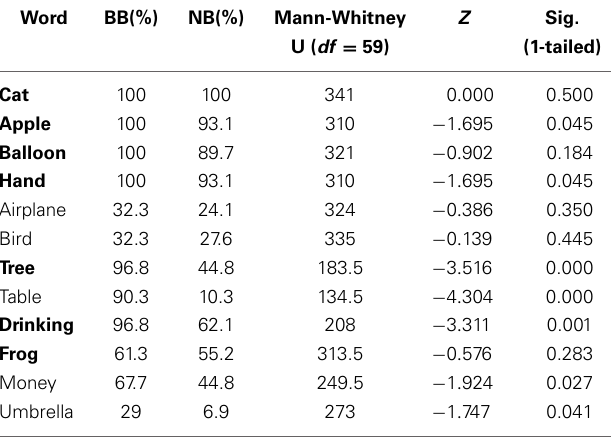
Table 5 | Percentages of correct answers and Mann-Whitney U, Z, and p for between-groups comparisons of number of correct answers for cognate and non-cognate words in the bilingually-based and the native language-based